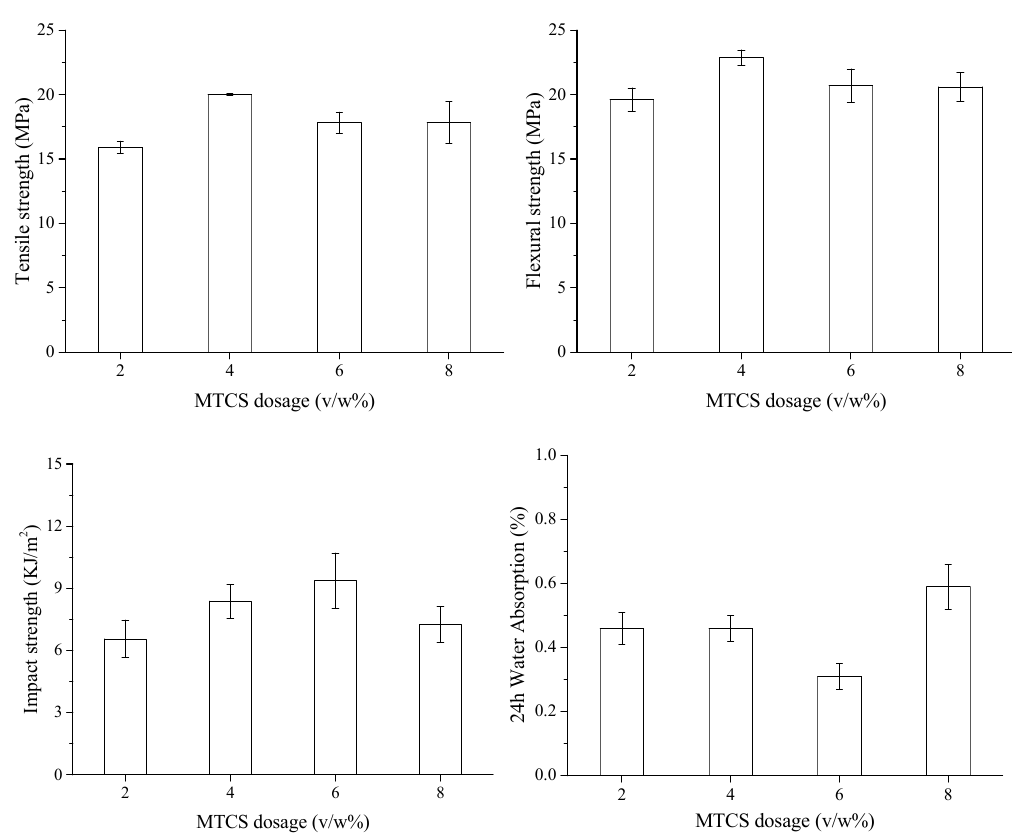
Figure 6. Impacts of MTCS dosages on mechanical properties and water resistance of ONP/HDPE